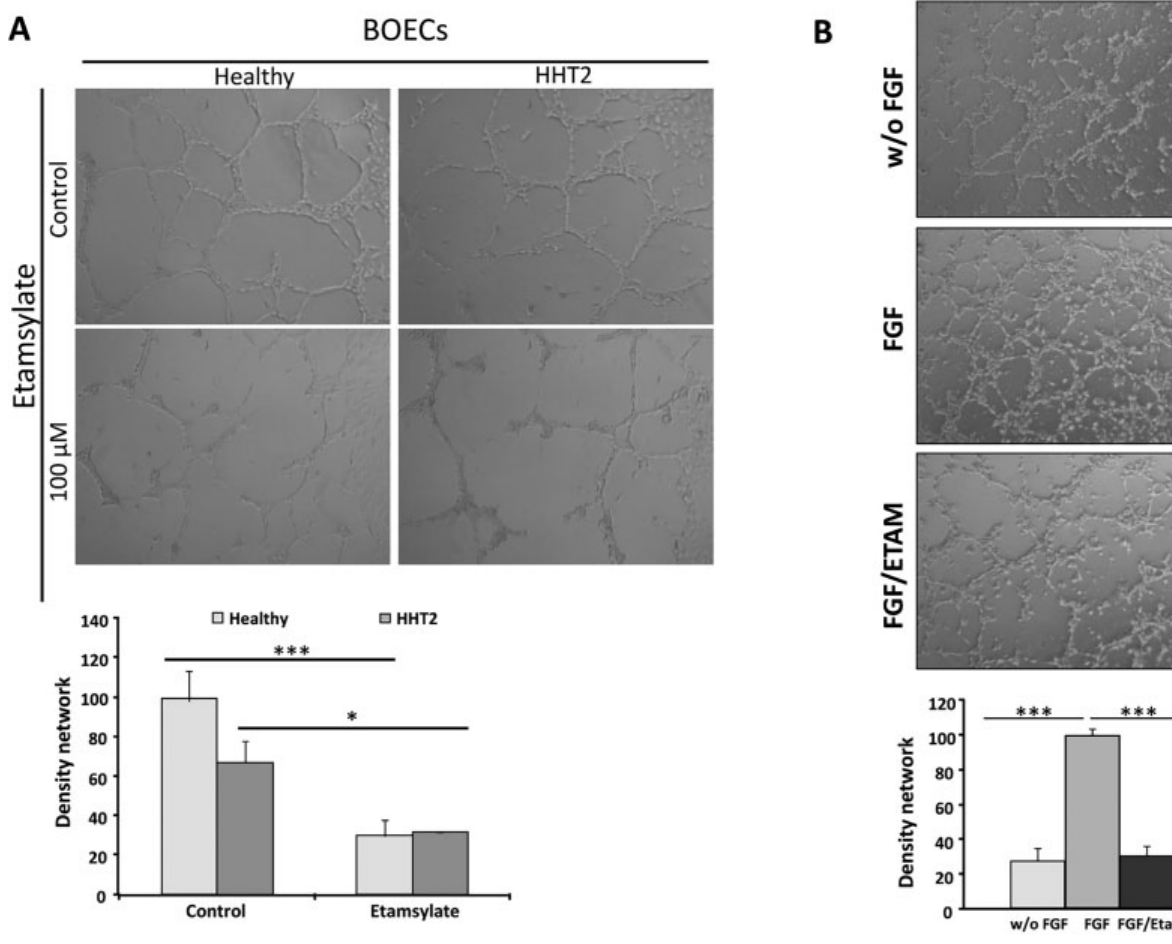
Fig. 3 ( A ) Effect of etamsylate on tubulogenesis assay in BOECs. Representative images demonstrate a lower amount of tubes in the treated cells. The different tube densities are shown in the graph. The number ofclosed tubules was counted in fi ve different fi elds and the mean was calculated. The mean with SD is shown. Statistical signi fi cance was studied using Student ’ s t -test (healthy: p < 0.002; HHT: p < 0.023). ( B ) Tubulogenesis assay FGF vs. FGF/ etamsylate.HHTBOECsweretreatedwithorwithoutFGFandetamsylate.Thenumberofclosedtubuleswascountedin fi vedifferent fi eldsandthemeanwas calculated. The images and graph show a signi fi cant decrease in the number of closed tubes when cells are without FGF ( (cid:3)(cid:3)(cid:3) p < 2.6 (cid:1) 10 (cid:5) 6 ), and when etamsylate is added in the presence of FGF (FGF/etamsylate; (cid:3)(cid:3)(cid:3) p < 1.1 (cid:1) 10 (cid:5) 6 ) in comparison with FGF-treated cells (FGF). BOECs, blood outgrowth endothelial cells; FGF, fi broblast growth factor; HHT, hereditary hemorrhagic